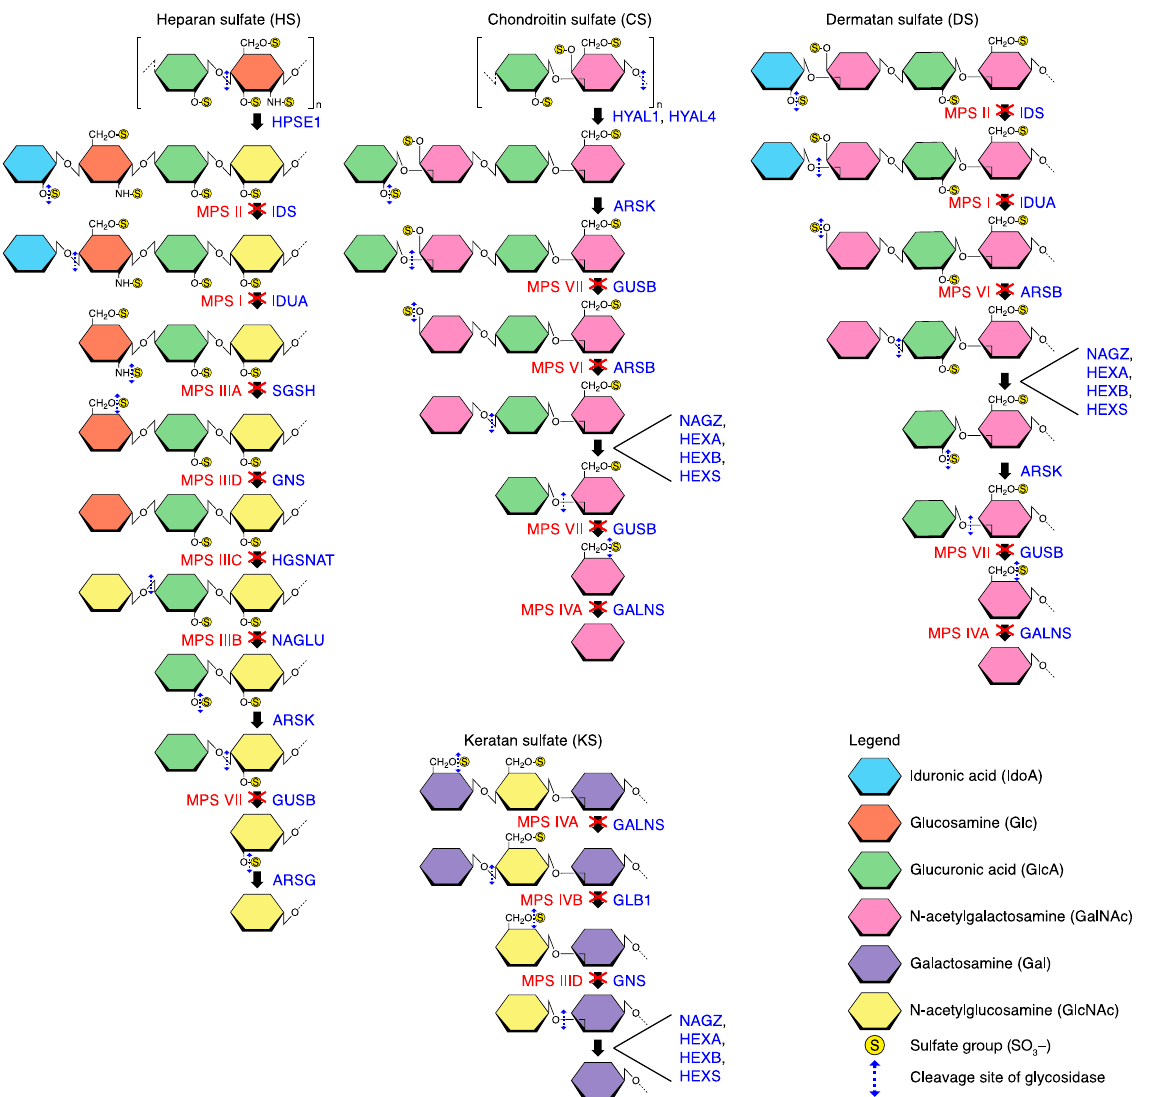
Figure 1. Degradation of the sulfated GAG chains. The deficient enzymes involved in the different MPS subtypes are indicated. HYAL1/4 and HPSE1 are endoglycosydases capable of degrading long chains of CS and HS, respectively, into smaller fragments. Degradation of GAGs consists in repeating steps of desulfation and deglycosylation at the non-reducing end of the chain by sulfatase and exogly- cosydase, respectively. Enzymes involved in the catabolism of GAGs and in MPS subtypes associated are indicated. ARSB (arylsulfatase B); ARSG (arylsulfatase G); ARSK (arylsulfatase K); GALNS